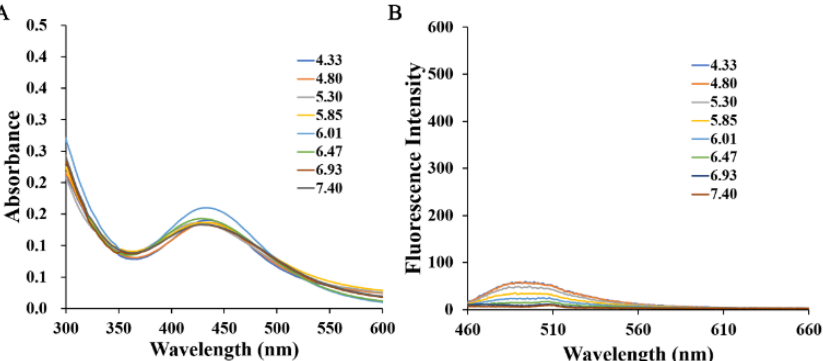
Figure 4. ( A ) Normalized absorption spectra of H6M (5 μ M) at various pH values (4.33–7.40) and ( B ) fluorescence emission spectra of H6M (5 μ M) in 10% DMSO aqueous ( λ ex = 450 nm).